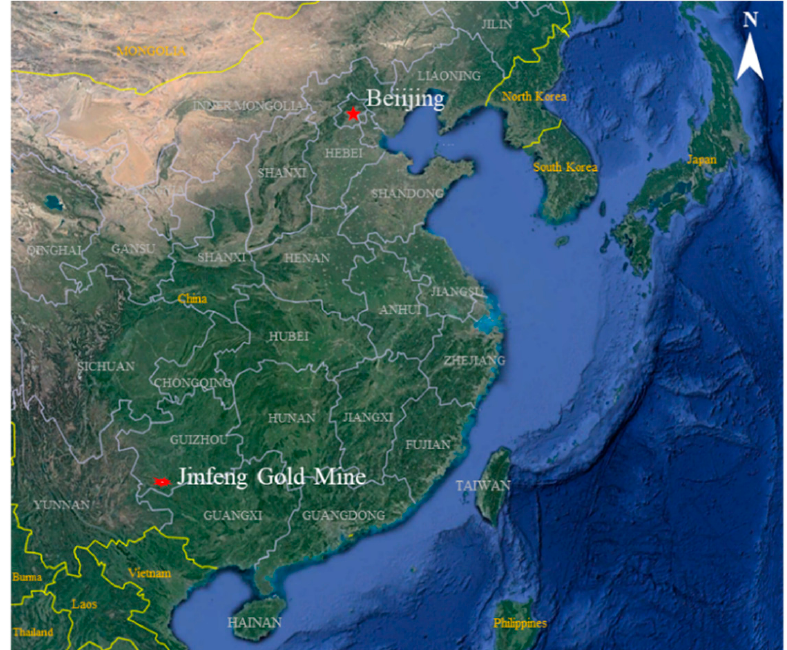
Figure 1. Location of the Jinfeng Gold Mine.